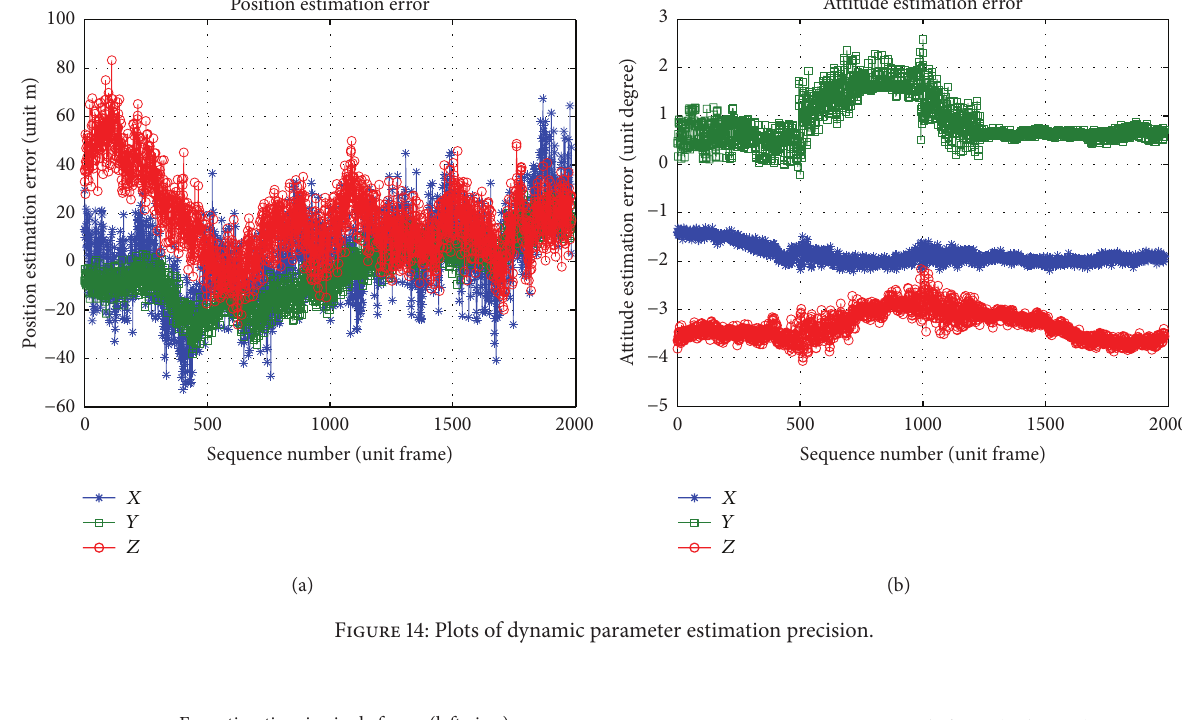
Figure 14: Plots of dynamic parameter estimation precision.